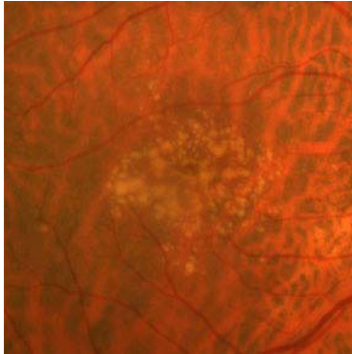
Figure 1. Drusen in non-neovascular age-related macular degeneration appear as round, yellow deposits deep in the retina during fundus